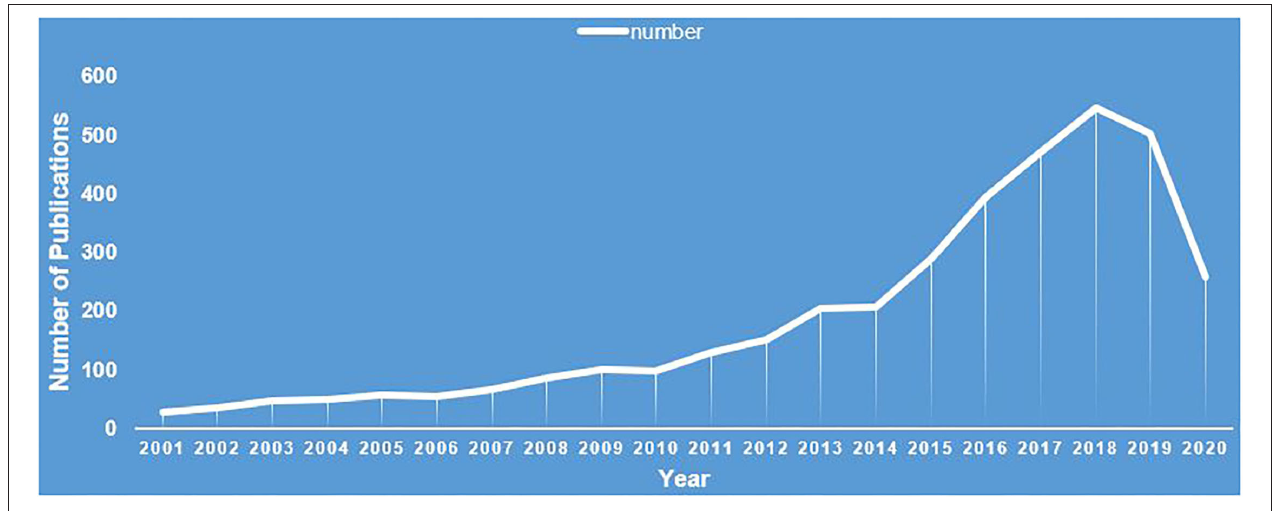
FIGURE 2 | Annual number of publications on complementary and alternative medicine for substance use disorders.